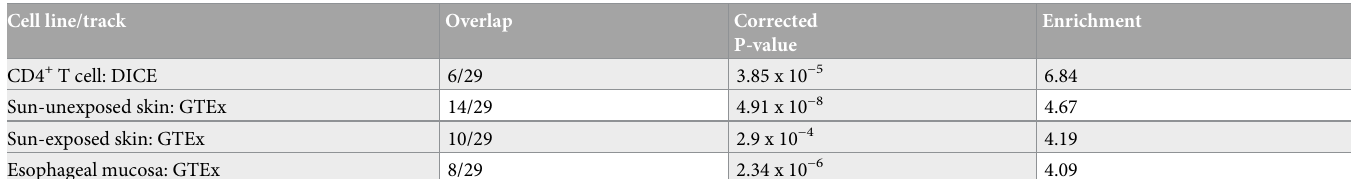
Table 1. Expression quantitative trait loci (eQTL) enrichment at atopic dermatitis (AD) risk loci. Application of our regulatory element locus intersection (RELI) method [21] to 3,143 AD variants across 29 independent risk loci using eQTL data obtained from the Genotype-Tissue Expression (GTeX) database [22] and the Database of Immune Cell Expression, eQTL and Epigenomics (DICE) [23].